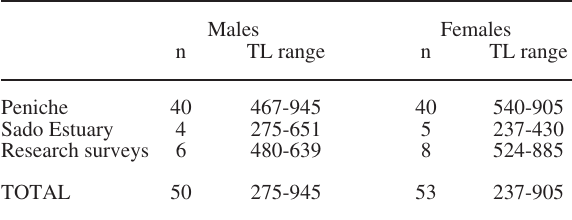
Table 2. – number of sampled specimens (n) and their total length (TL) and range (in mm) in each sample source.